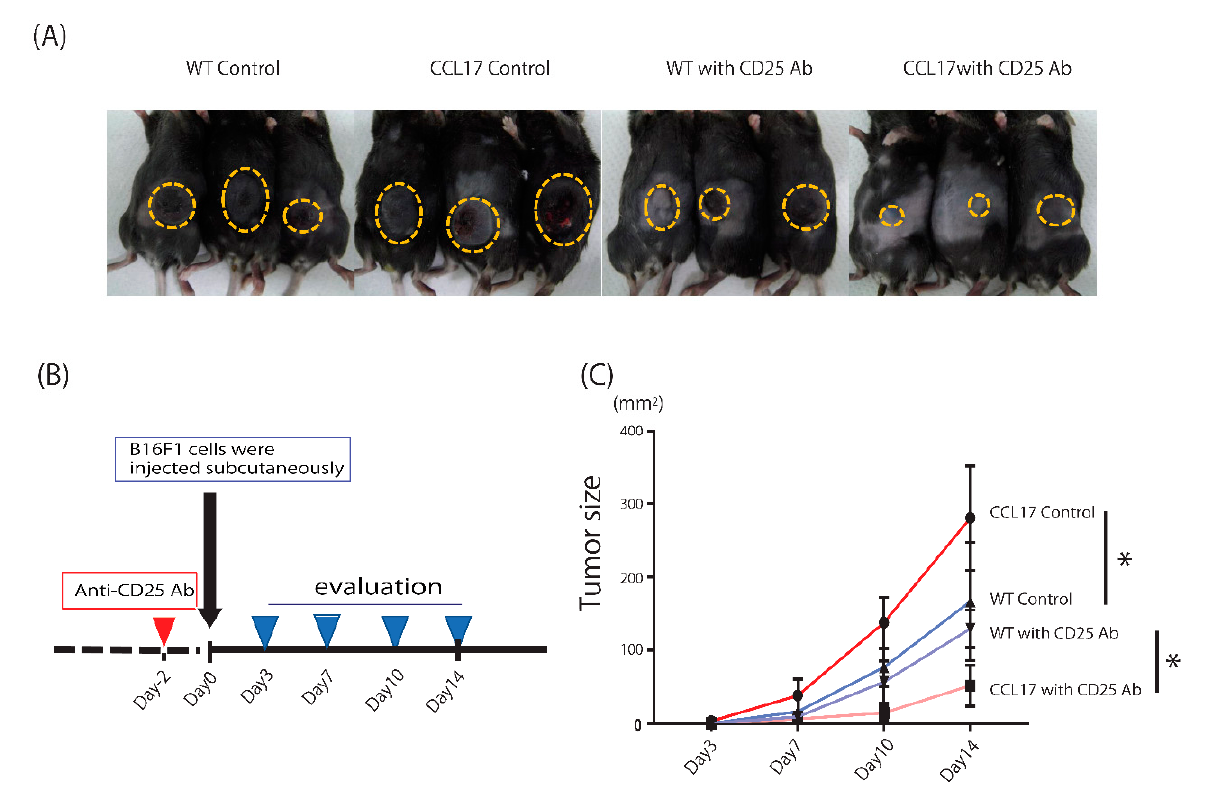
Figure 5. Tumor immunity was markedly enhanced by depletion of regulatory T cells (Tregs) in CCL17 transgenic (TG) mice. ( A ) Phenotypical manifestation of back skin from wild-type (WT) and CCL17 TG mice treated with anti-CD25 Ab or phosphate-buffered saline (PBS) peritoneally 14 days after injection of B16F1 cells subcutaneously. ( B ) Schema describing strategy for Tregs depletion with anti-CD25 Ab. Anti-CD25 Ab was injected peritoneally two days before subcutaneous inoculation of B16F1 cells and tumor sizes were evaluated on days 3, 7, 10, and 14. ( C ) Tumor size was dramatically decreased in CCL17 TG mice treated with anti-CD25 Ab compared with that in WT treated with anti-CD25 Ab and that in CCL17 TG mice treated with PBS. * p < 0.05, ** p < 0.01.